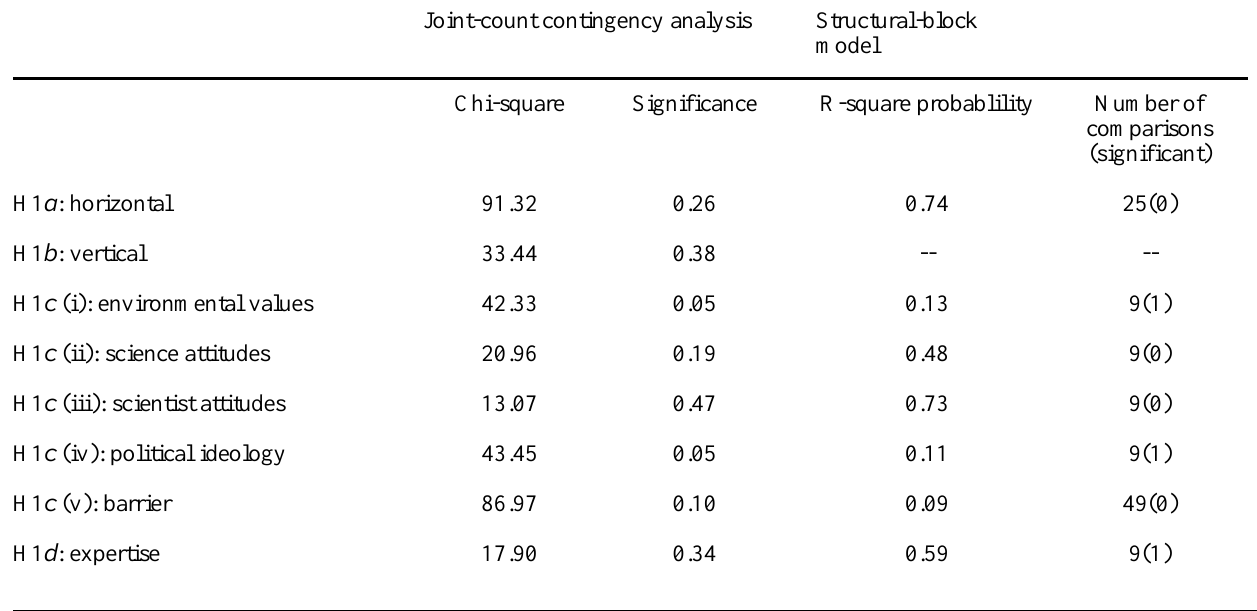
Table 2. Tests for respondent attribute affilliation with tie frequency across and within horizonal and vertical scope, worldview characteristic (environmental values, science attitudes, scientist attitudes, political ideology, and barriers to decision making), and expertise